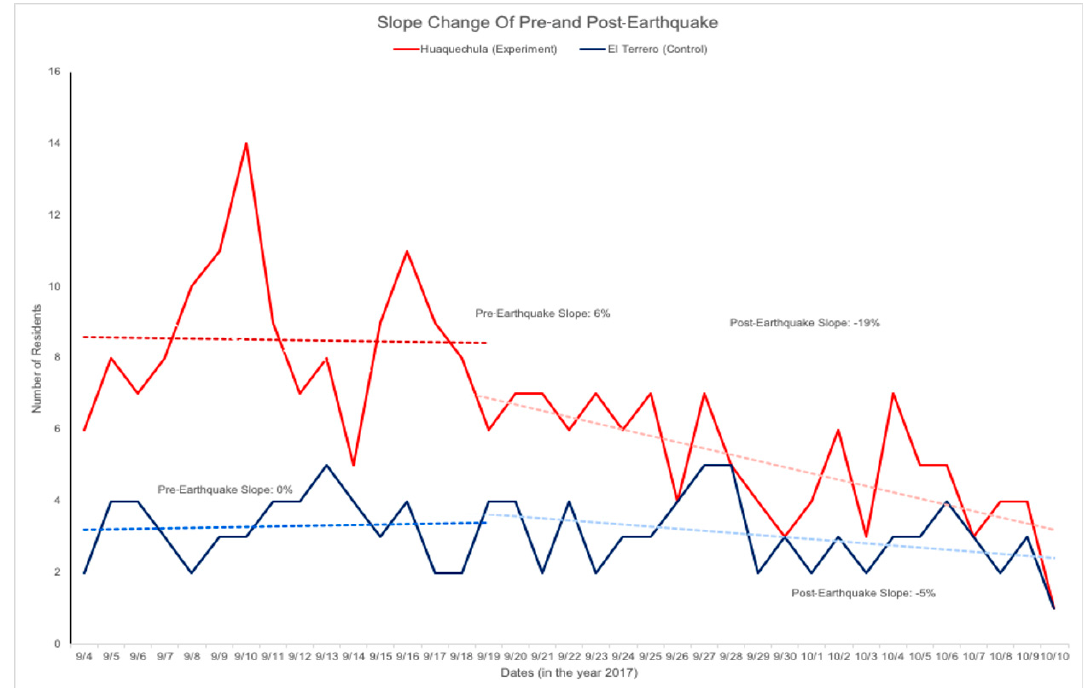
Figure 8. This approach detected a locality as depopulating if the pre-earthquake slope of residents was 24% lower than the post-earthquake slope of residents. In this figure, the experiment locality Huaquechula had a consistent percent of residents (6% slope) before the earthquake but saw a steady decline in residents after the earthquake ( − 19%), while the control locality El Terrero maintained a steady percent of its residents both before (0%) and after ( − 5%).